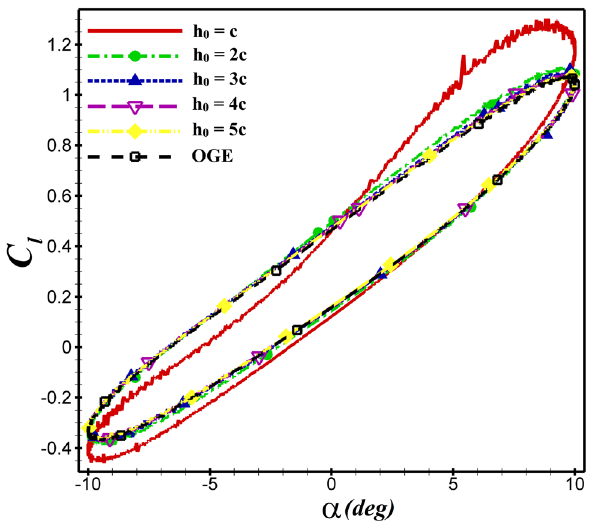
Figure 12. The C l of NACA 4412 airfoil in different h 0 over one oscillation period.